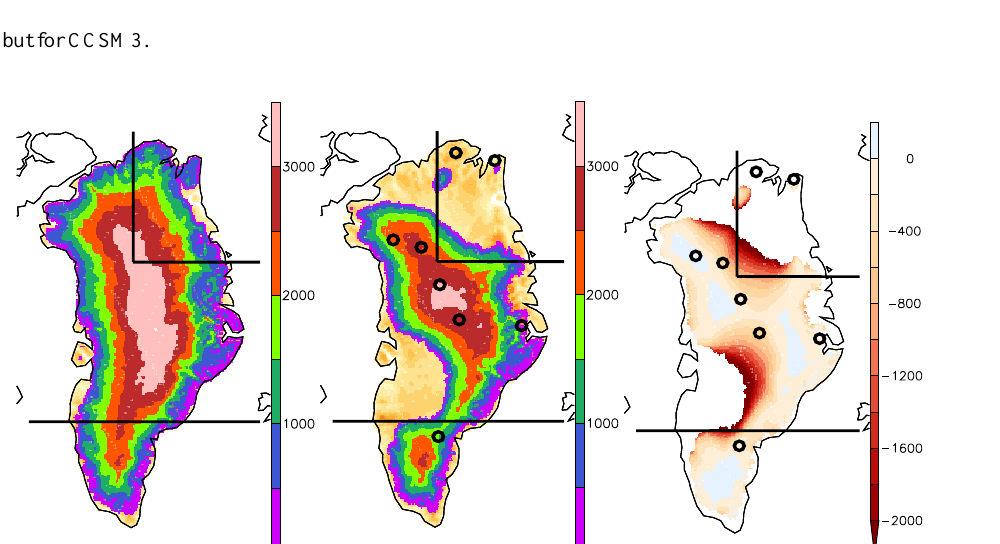
Fig. 4. As figure 2, but for CCSM3. Fig. 4. As Fig. 2, but for CCSM3.